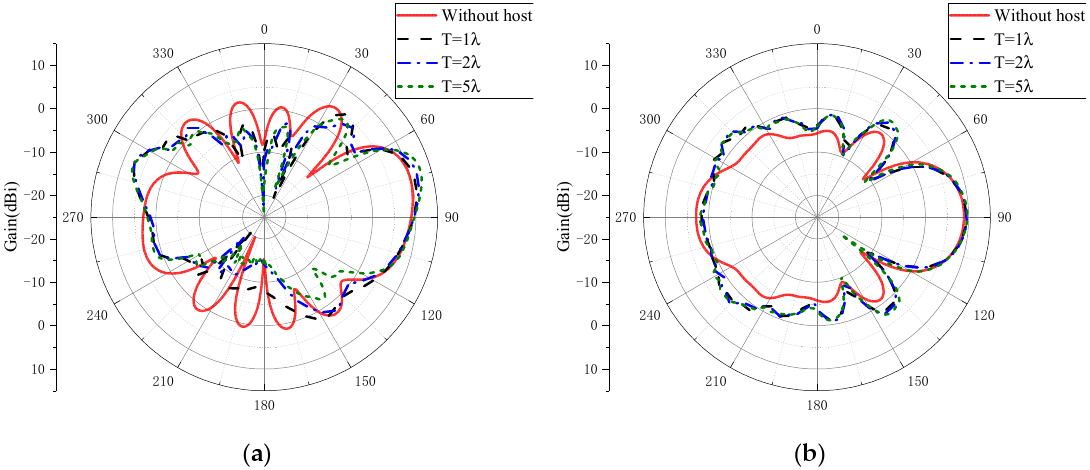
Figure 14. Simulated radiation patterns of the proposed antenna with conducting cylinder at frequency of 6 GHz: ( a ) EL plane; ( b ) AZ plane.